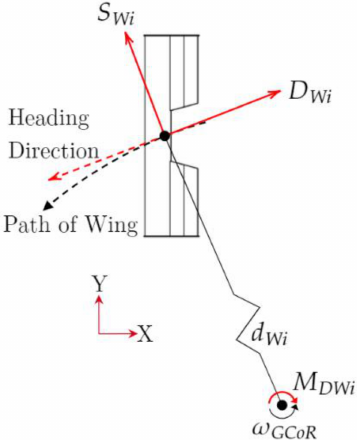
Figure 11. A schematic diagram showing the direction of the drag force and side-force vectors under the cornering condition; d Wi denotes the absolute distance between the centre of pressure and the